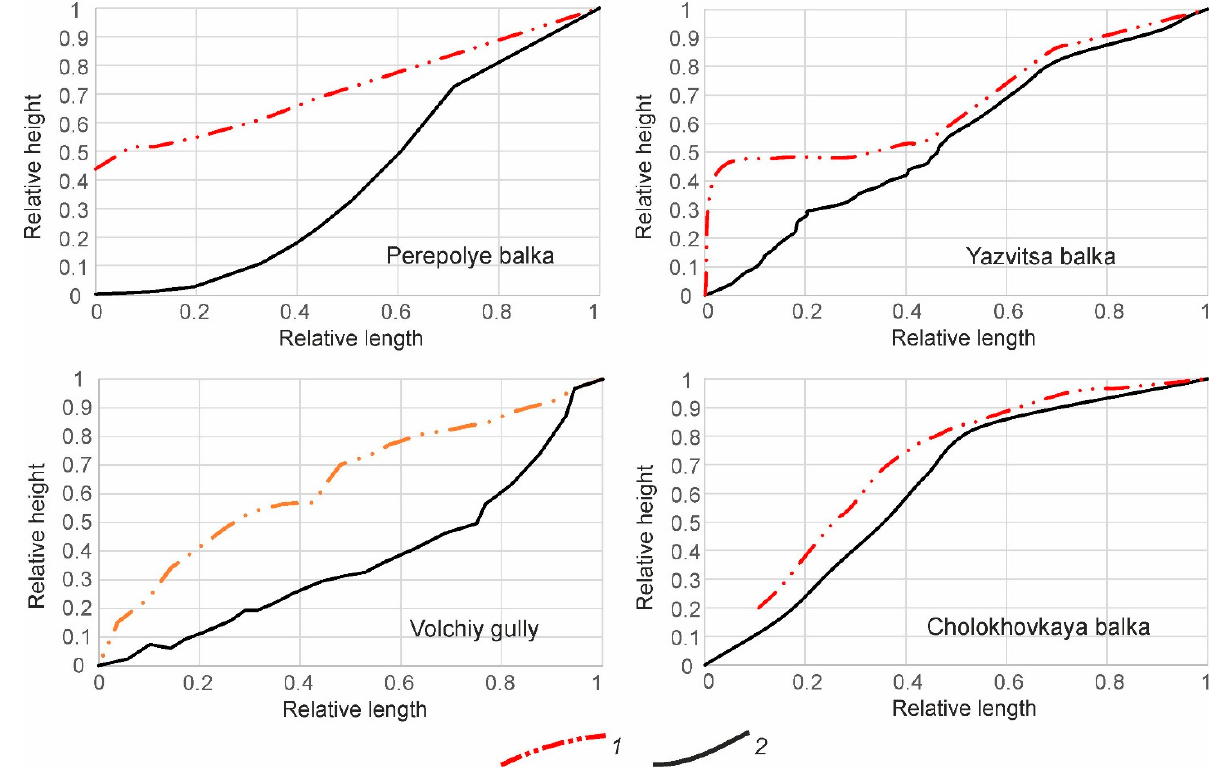
Figure 15. Comparison of the longitudinal profiles of the erosional forms, situated in the extraglacial part of the East European Plain (the Perepolye Balka) and in its part glaciated during MIS 6 (Yazvitsa and Cholokhovskaya Balkas, Volchiy gully). Keys: 1—initial slope, 2—gully bed.